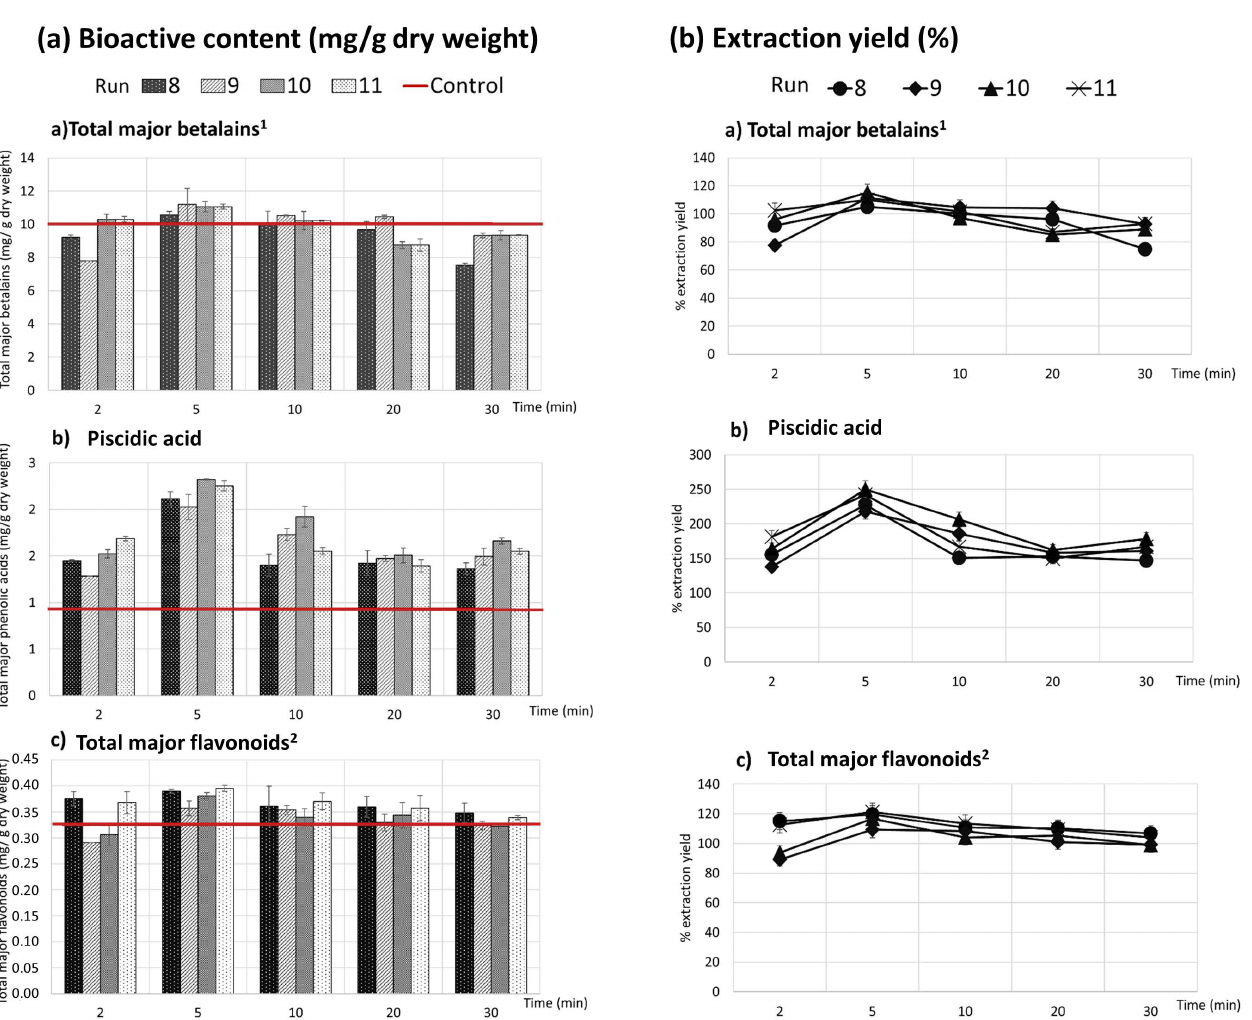
Figure 1. Process time effect on the content of major bioactive compounds and extraction yield of total major betalains, piscidic acid and flavonoids: 1 the sum of most abundant betalains: betanin, isobetanin, 2 (cid:48) -O-apiosyl-4-O-phyllocactin, 5 (cid:48)(cid:48) -O-E-sinapoyl-2 (cid:48) -apyosil-phyllcactin and neobetanin, 2 the sum of most abundant flavonoids: Isorhamnetin glucoxyl- rhamnosyl-pentoside (IG2), Quercetin-3-O-rhamnosyl-rutinoside (QG3) and Quercetin glycoside (QG2)—Quercetin hexose pentoside, obtained after selected UAE treatments: run 8 (35% amplitude, 47,5% ethanol in solvent ( v / v ), 60 ◦ C temperature); run 9 (20% amplitude, 15% ethanol in solvent ( v / v ); 50 ◦ C temperature); run 10 (50% amplitude, 15% ethanol in solvent ( v / v ); 20 ◦ C temperature); and run 11 (35% amplitude, 47,5% ethanol in solvent ( v / v ); 35 ◦ C